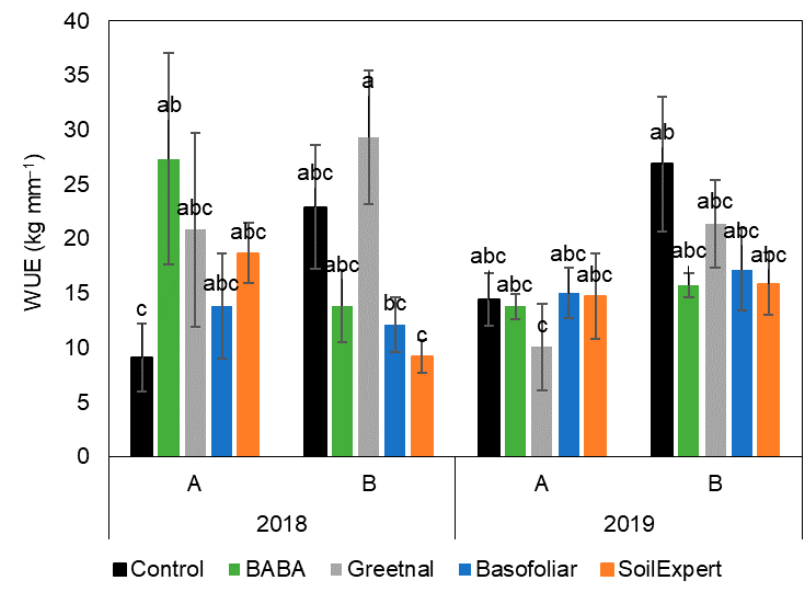
Figure 4. Water use efficiency (kg mm − 1 ) in plants of Vitis vinifera var. Tempranillo from two subplots (A and B) sprayed with distilled water (C), BABA, or three commercial biostimulants (Greetnal, Basofoliar, or SoilExpert) in the 2018 or 2019 season. Different letters indicated significant differences according to Duncan’s test after ANOVA.